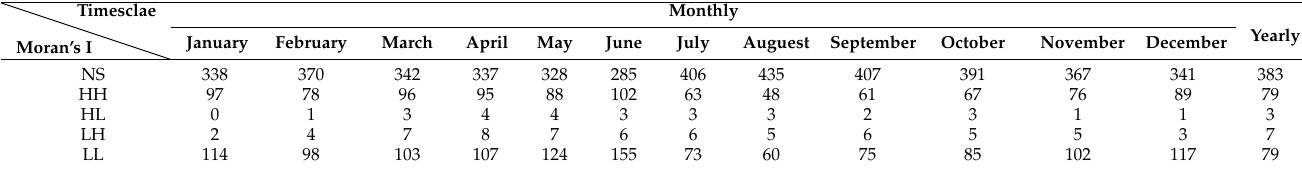
Table 4. The site numbers of Anselin Local Moran’s I index for D